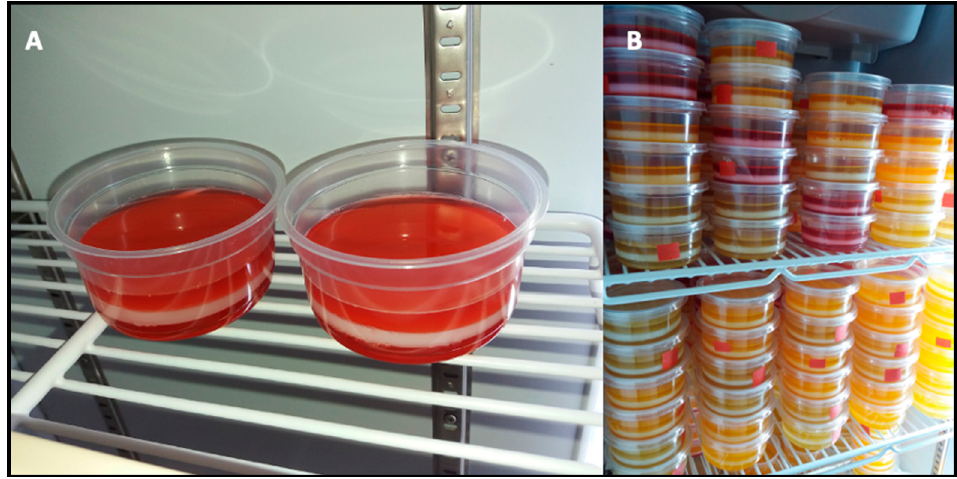
Figure 2. ( A ) Three-layer probiotic-supplemented gelatin ( right ) and three-layer placebo-supple- mented gelatin ( left ), the probiotic was included in the middle layer; ( B ) refrigerated gelatins in storage to be distributed to the